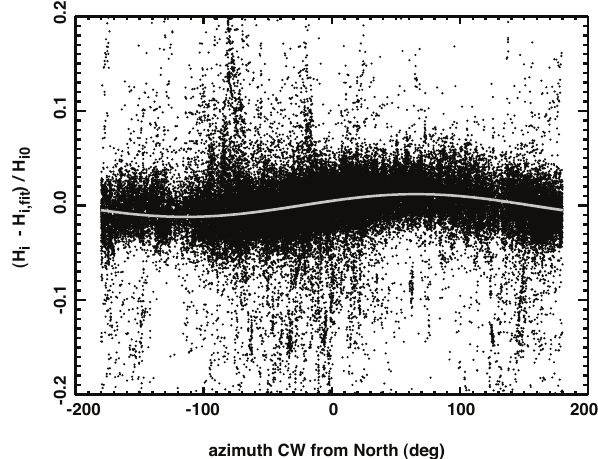
Fig. 6. Scatter plot of scaled height (that is, divided by the mod- eled height at the appropriate zenith angle but at short range) versus scaled range, for all 65000 height retrievals.